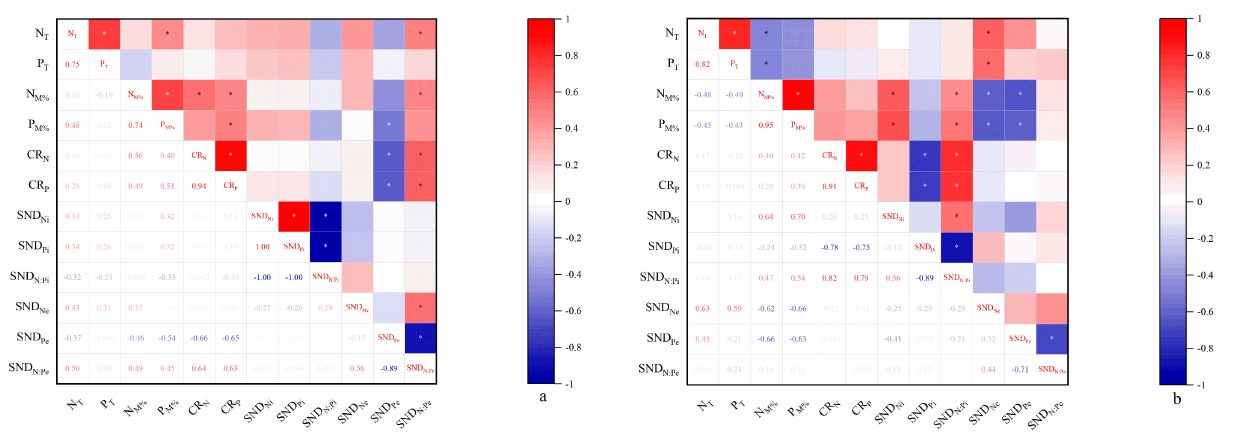
Figure 6. Correlations between nutrient competitiveness, nutrient uptake, and soil nutrition status at ( a ) cut 1 and ( b ) cut 2 N M% and P M% : proportion of lucerne N and P uptake, respectively; N T and P T : total N and P uptake, respectively, in the mixtures; SND N : soil N density; SND P : soil P density; SND N:P : soil N:P density ratio; i: at the initial stage; e: at the flowering stage. Asterisks (*) show a significant correlation at p <